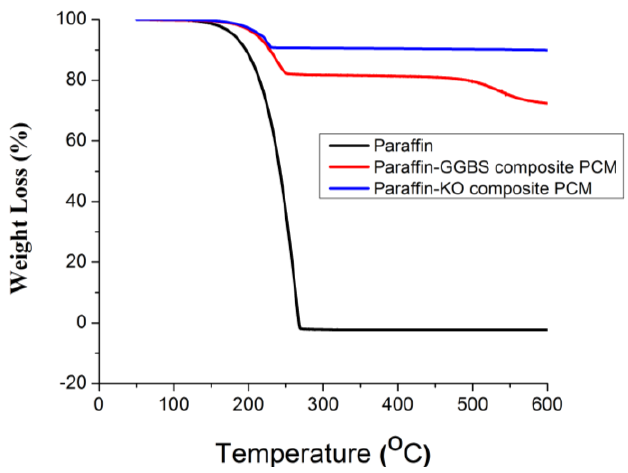
Figure 7. TGA thermograms of the paraffin and